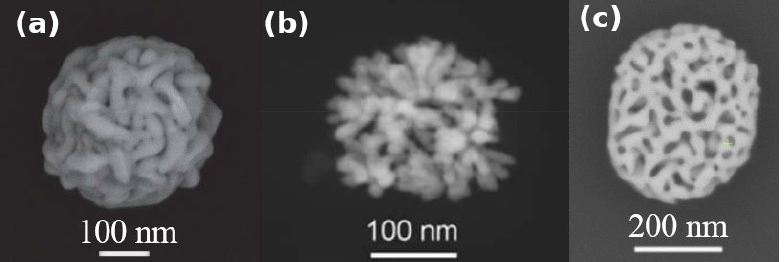
Figure 5. SEM images of colloidal PGNs prepared by using fundamentally different methods: ( a ) Colloidal PGNs prepared by Pedireddy et al. [31] ( b ) Colloidal PGNs prepared by Hu et al. [30] ( c ) Colloidal PGNs prepared by using the dewetting-dealloying method reported in this paper. Figures were reproduced by permission of Springer Nature and RSC